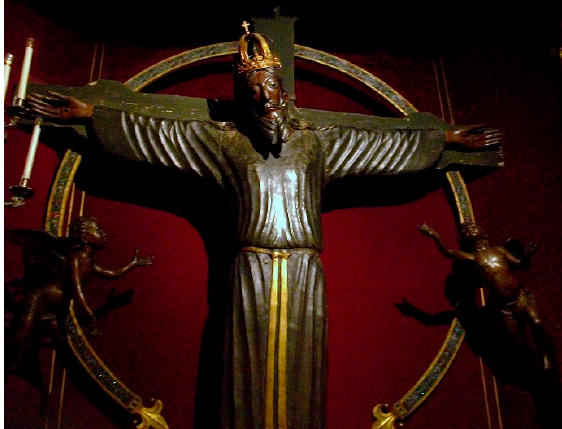
Figure 11. The Volto Santo. Polychrome wood, c .1200. Lucca cathedral. Photo: Wikipedia Commons.